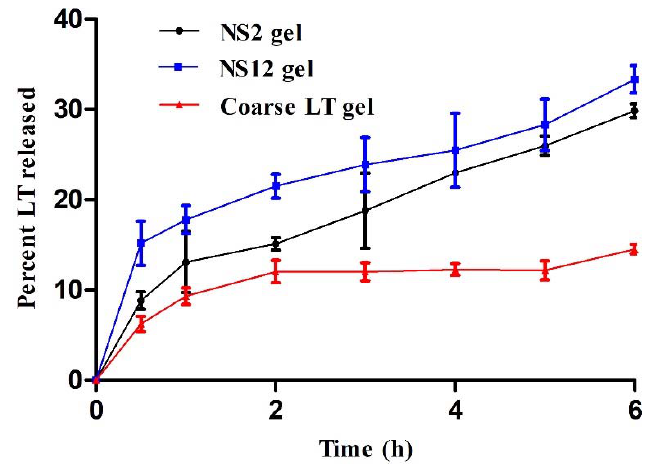
Figure 6. In vitro release profiles of LT from NS2, NS12, and coarse LT gels (mean values ± SD, n = 3). Table 2. Kinetic parameters for the in vitro release of LT from NS2, NS12, and coarse LT gels. Zero-Order Code